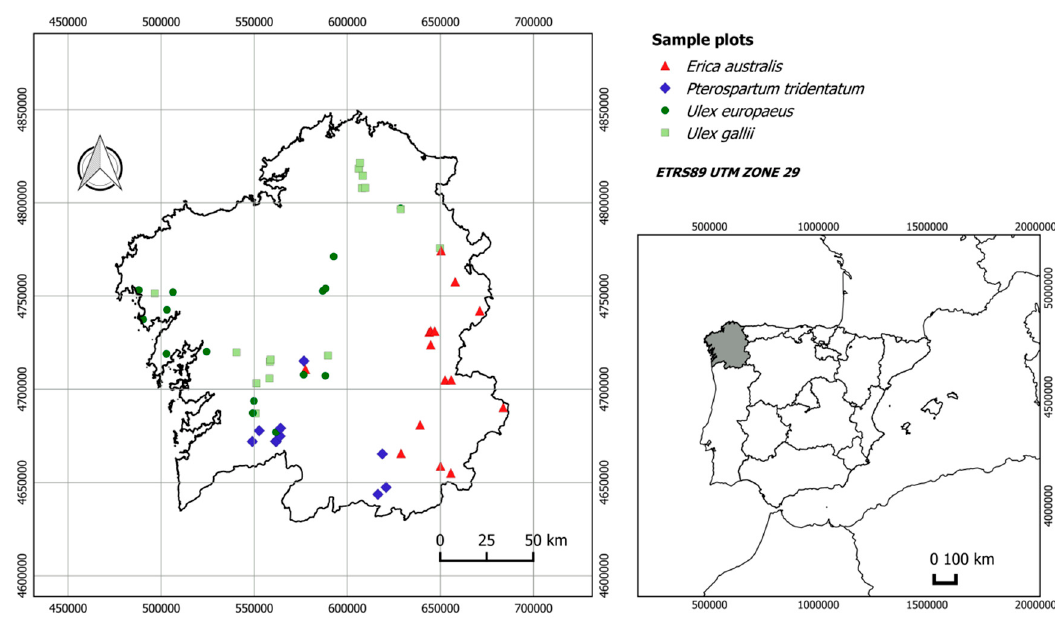
Figure 1. Geographical location of the 55 plots in Galicia grouped in 4 shrub communities.